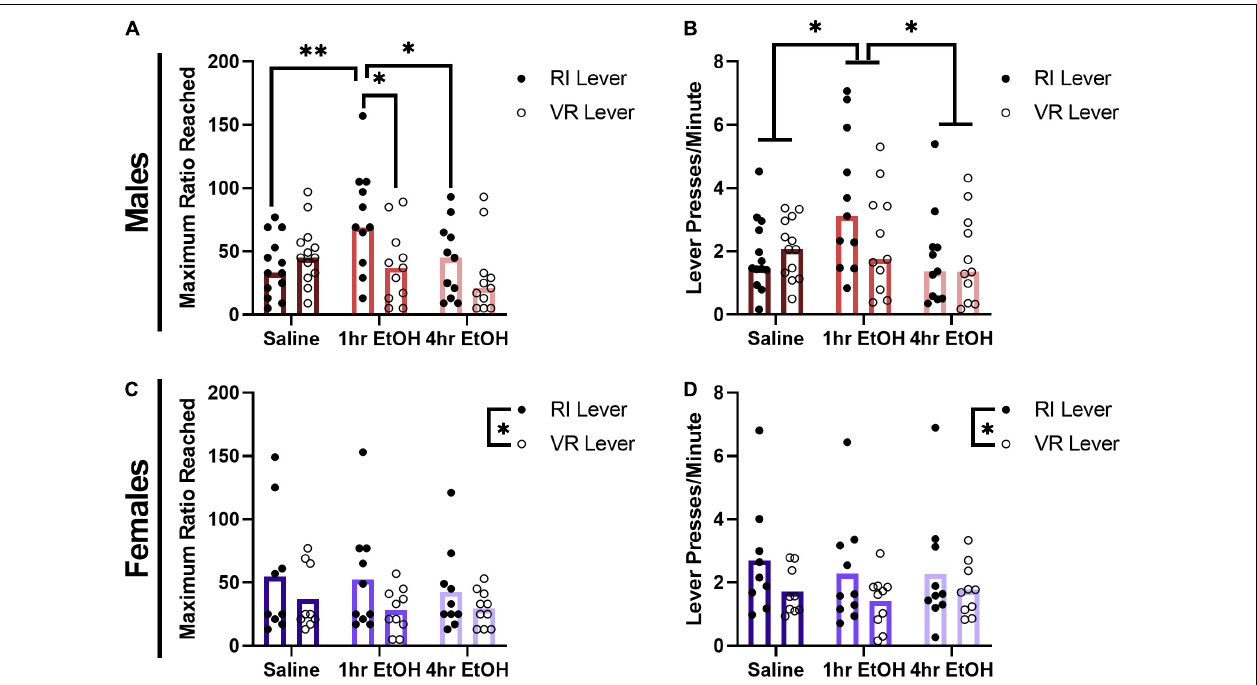
FIGURE 3 | Effect of low dose ethanol on sucrose reward motivation depends on sex and reinforcement schedule. (A) Male mice with a history of 1 h EtOH exposure are significantly more motivated for sucrose, but only on the RI lever. (B) One hour EtOH male mice also exhibit significantly higher response rates during the PR. (C) Female mice are more motivated for sucrose on the RI lever, regardless of exposure history. (D) Female mice also exhibit higher response rates on the RI lever during PR testing. Data shown as mean ± SEM ( ∗ p < 0.05, ∗∗ p < 0.01).